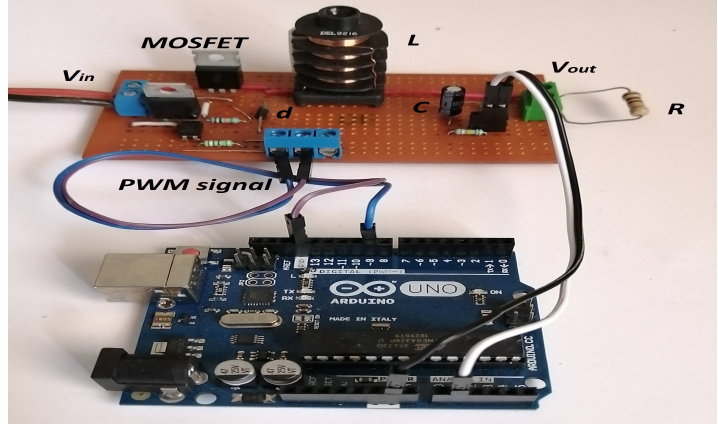
Figure 18. Buck converter experimental platform.